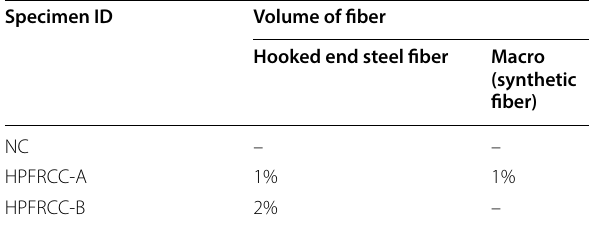
Fig. 3 Fibers used in this research: a hybrid macro synthetic fiber; b Hooked end steel fiber.